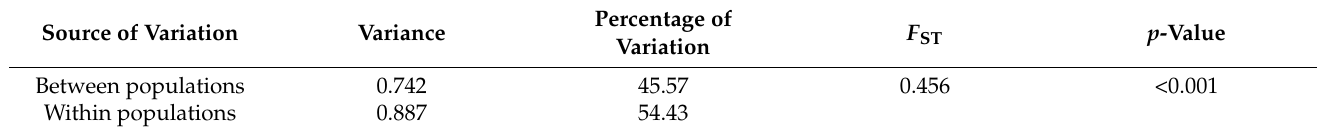
Table 3. Analysis of molecular variance (AMOVA) results for the genetic structure of N. phocaenoides divided into two groups (ES and W) based on the mtDNA control region